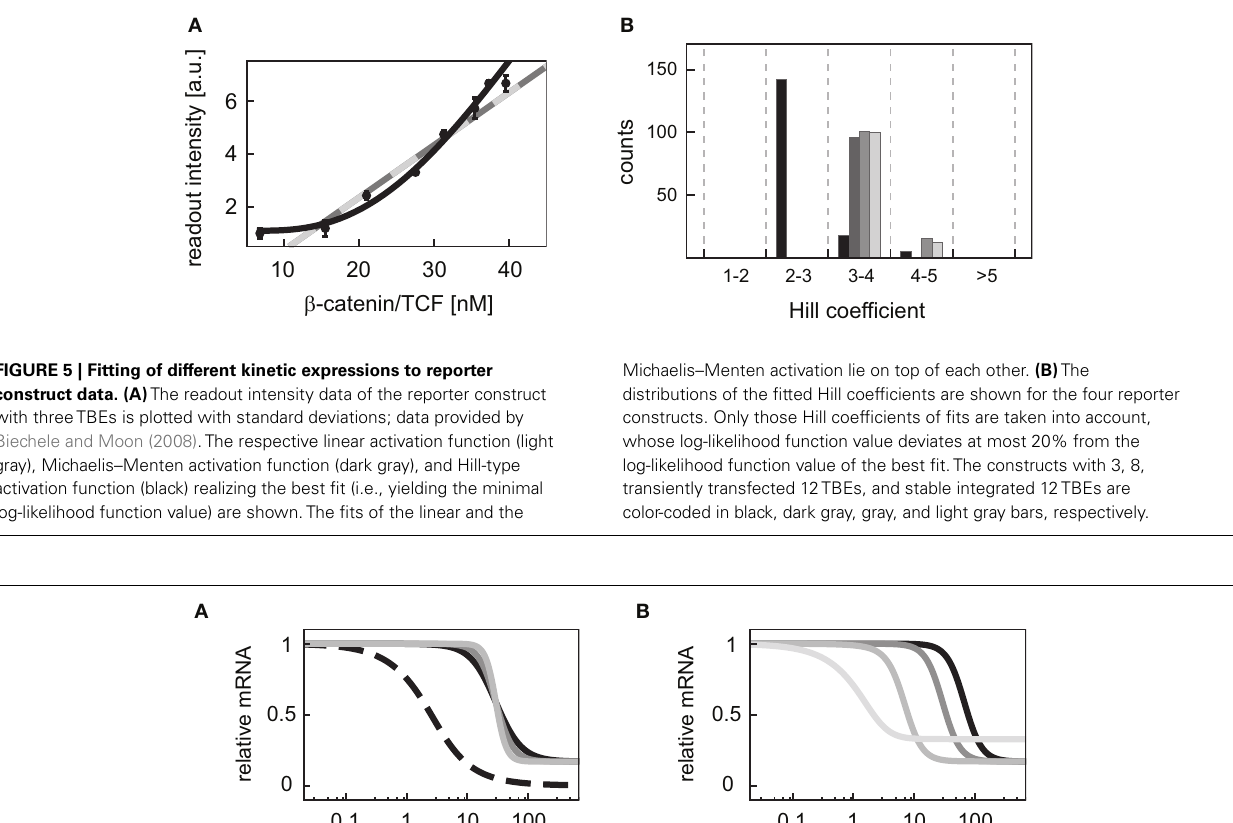
steady state concentration of the target gene mRNA is compared assuming cooperative activation with K M values of 10, 23, 100, and 500nM (black, dark gray, gray, and light gray, respectively).The Hill coefficient is set to n = 3 in all cases. For each curve the steady state is normalized to the respective maximal mRNA concentration. (C,D) The absolute value of the concentration changes along the curves of (A,B) , respectively, are compared.The maximal calculated change in each panel is color-coded in